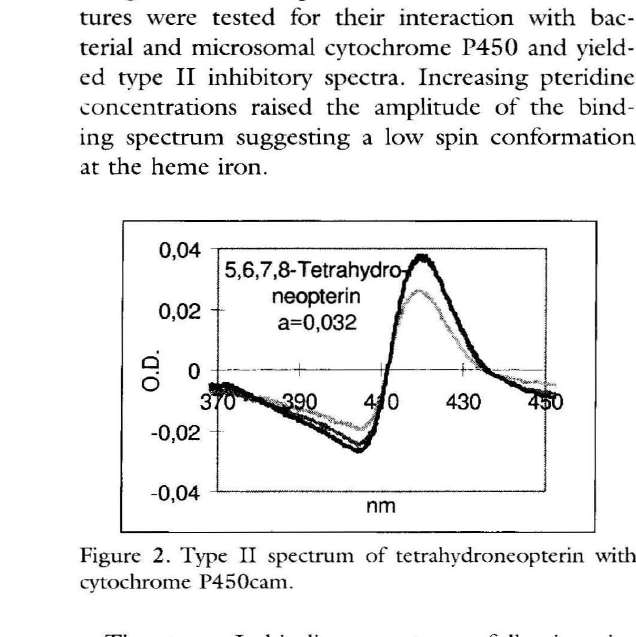
Figure 2. Type II spectrum of tetrahydroneopterin with cytochrome